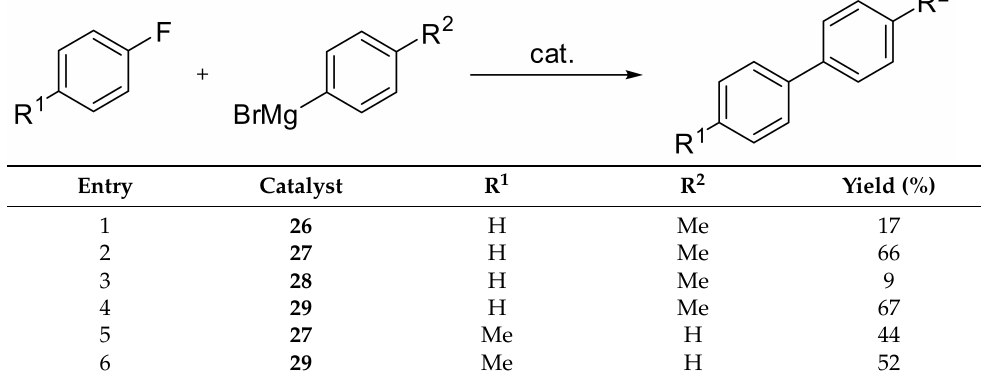
Table 3. Comparison of the catalytic performances of the unsymmetrical nickel pincer complexes 26 – 29 for the cross-coupling of aryl fluorides with aryl Grignard reagents. Adapted from